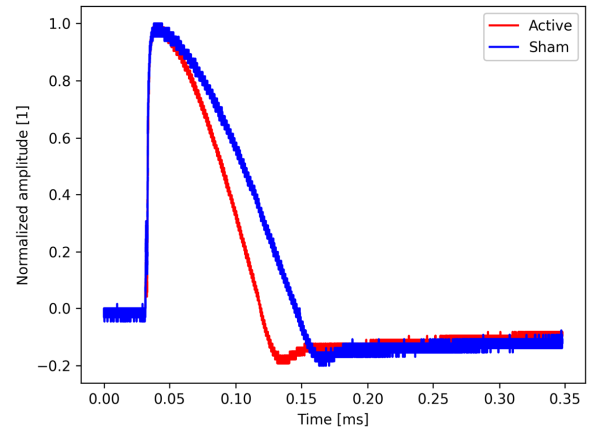
Figure 3. Monophasic waveform with active and sham coils. The horizontal axis shows the time and the vertical axis shows the amplitude normalized to 1 at the maximum value. The red line represents the active coil and the blue line indicates the sham coil.